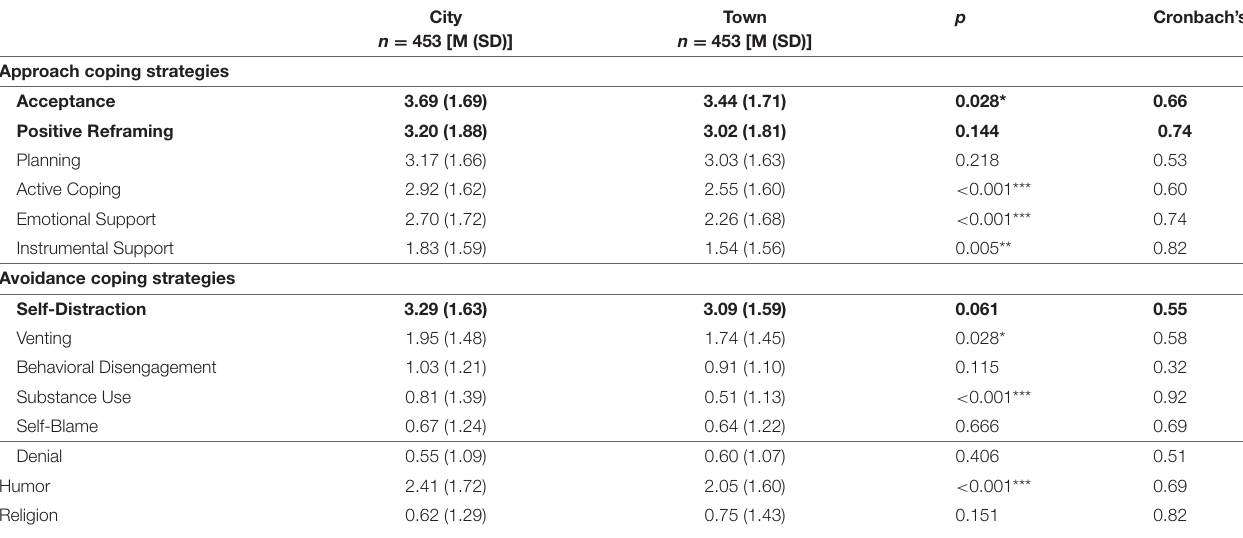
TABLE 4 | Coping strategies by subsamples after propensity score matching and results of group comparison between city sample and town sample.